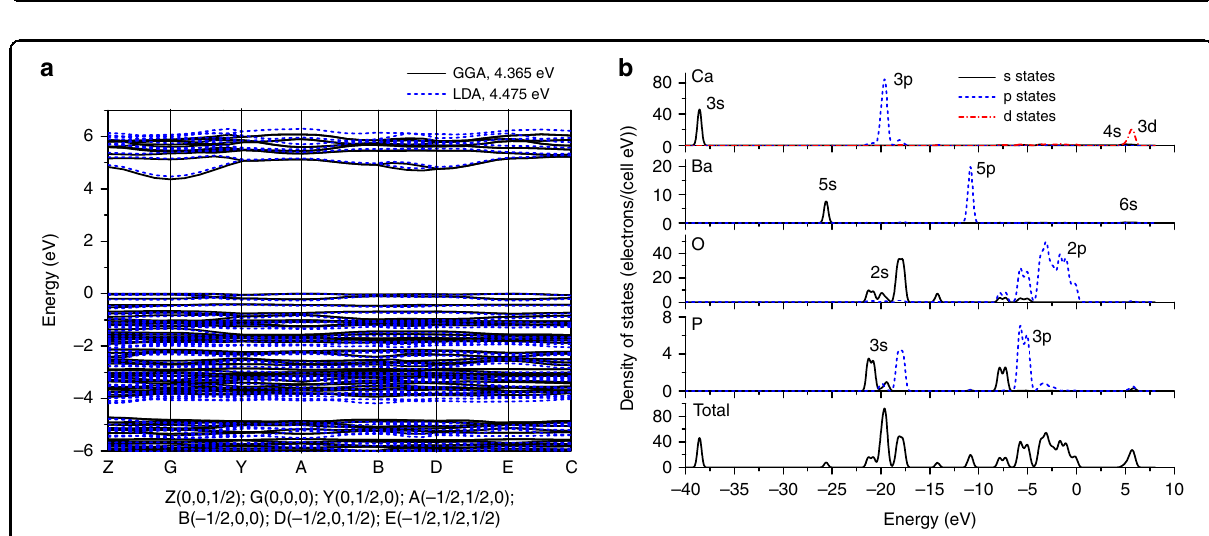
Fig. 1 The structure of Ca 6 Ba(PO 4 ) 4 O:Mn 5 + . a Rietveld fi ts for Ca 6 Ba(PO 4 ) 4 O, R wp = 5.31%. b Rietveld fi t for Ca 6 Ba(PO 4 ) 4 O:Mn 5 + , R wp = 8.59%. In each case the blue curve represents the observed pattern, the red curve is the calculated pattern and the difference curves are shown in grey, while blue tick marks represent the positions of the Bragg peaks. c The crystal structure of Ca 6 Ba(PO 4 ) 4 O, with the unit cell viewed along the b-axis; d Geometries of two PO